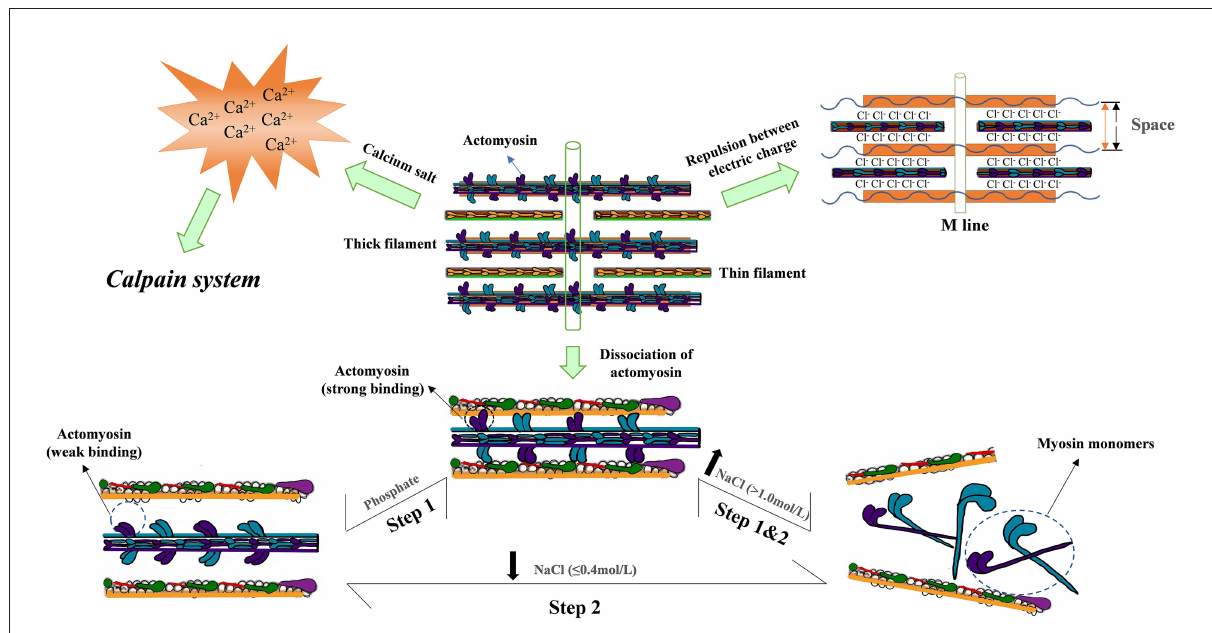
FIGURE5 Diagrammatic sketch of salt tenderization: Step 1 involves dissociation of actomyosin, and step 2 involves dissociation of myosin from the thick filament. Salt impacts both constraints whereas phosphate lowers the concentration of Sodium chloride for maximum myosin extraction from > 1.0 to 0.4 mol/L, primarily by weakening actomyosin